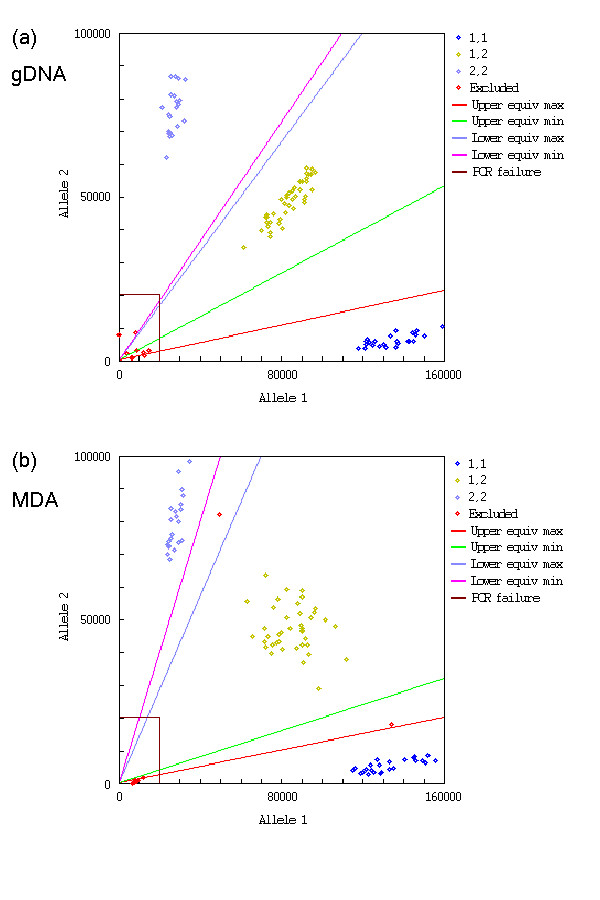
TaqMan fluorescence data plotted to compare the performance of MDA product with gDNA. This is a typical example of the clustering and scoring of TaqMan data for a common SNP in the evaluation of MDA product as a template for TaqMan genotyping. (a) End-point data from the 88 gDNA samples used in this evaluation and (b) the corresponding 88 MDA samples. In this example there are eight apparent failures for MDA, which are, in fact, empty wells. No genotypes were rejected for gDNA, and two genotypes were rejected for the MDA products due to poor clustering.